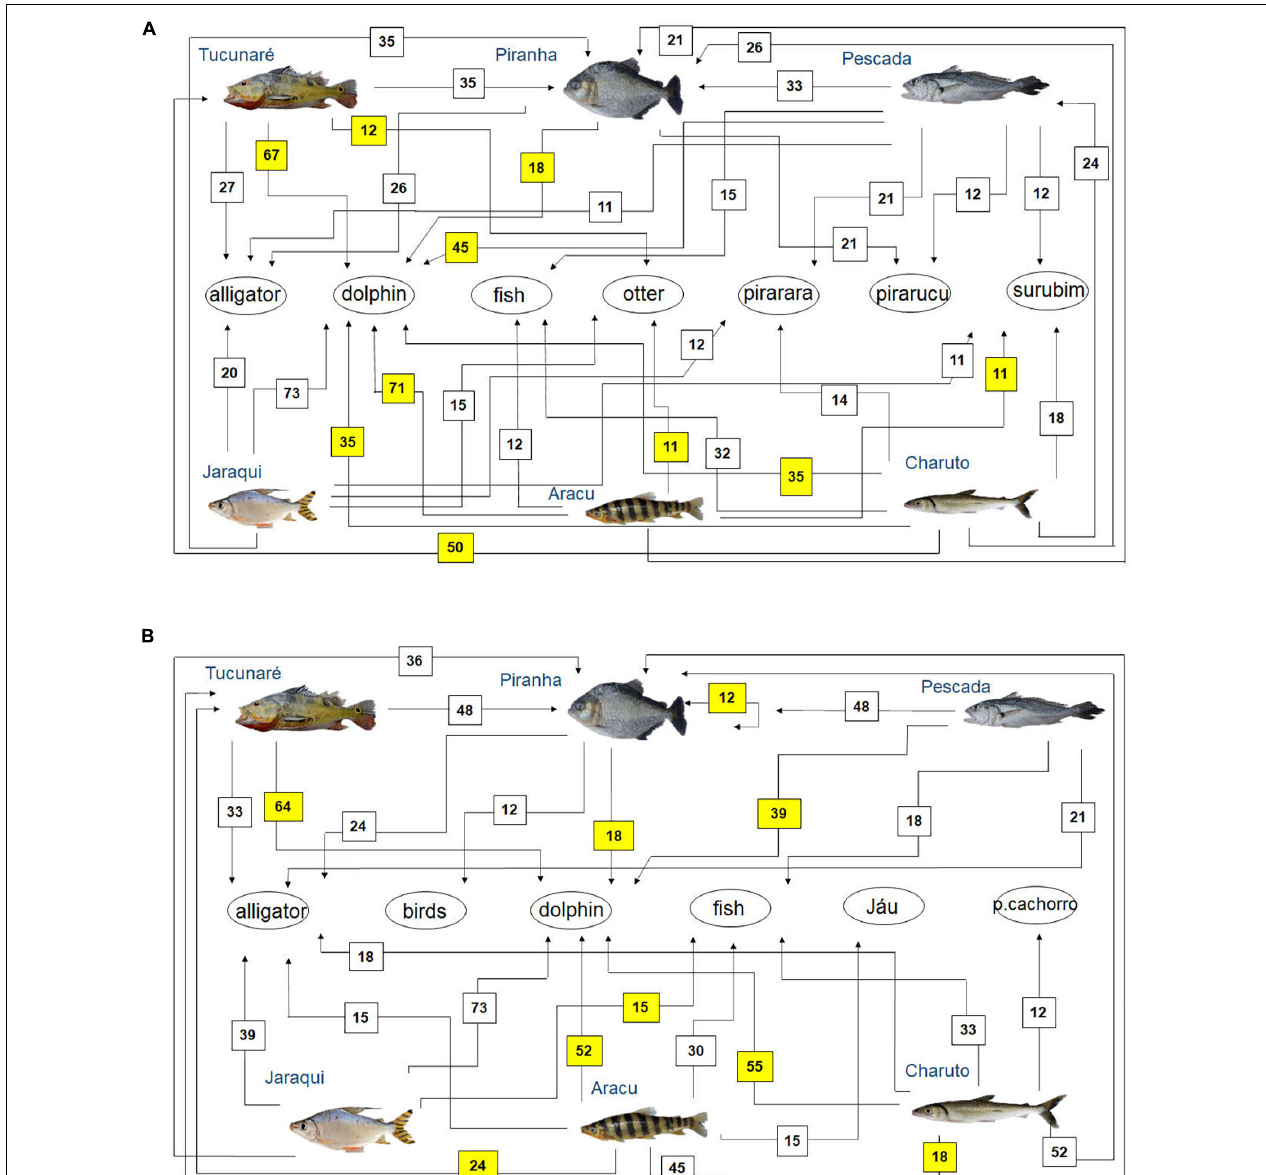
FIGURE 5 | Diagram representing fish feeding relationships (simplified food web) of the studied fish species, based on fishers’ local ecological knowledge about fish predators (question: Who eats this fish?) in the rivers (A) Tapajós ( n = 65 fishers) and (B) Tocantins ( n = 33 fishers), in the Brazilian Amazon. The numbers are the percentage of interviewed fishers who mentioned each feeding interaction. The sum may be greater than 100%, as fishers could cite more than one food item for each studied fish species. Those food interactions that agree with fish feeding relationships reported in the biological literature (Best, 1984; Silva et al., 2013; Dary et al., 2017; Jacobi et al., 2020) are marked in